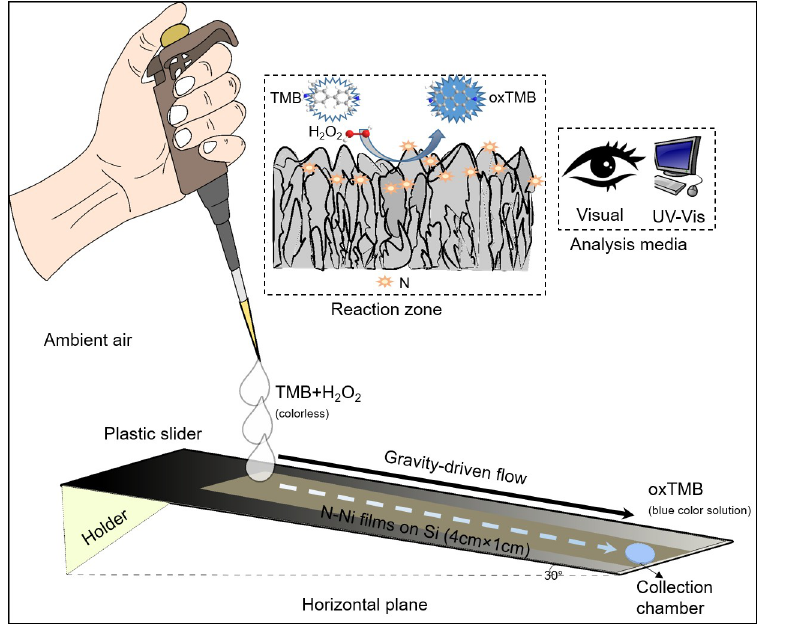
Fig 7. Schematic representation of gravity assisted flow